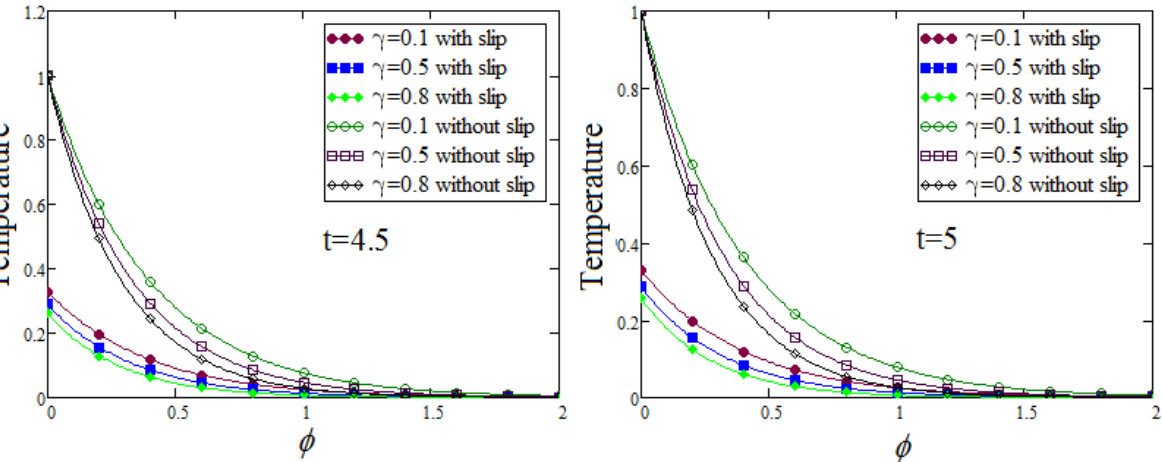
Figure 4. Graphical representations of temperature profile in the presence of slip and no slip condi- tions by taking the distinct values of γ at two different levels of time, when Pr = 12, ω = 0.5, ℘ = 0.4, β = 0.3, and α =